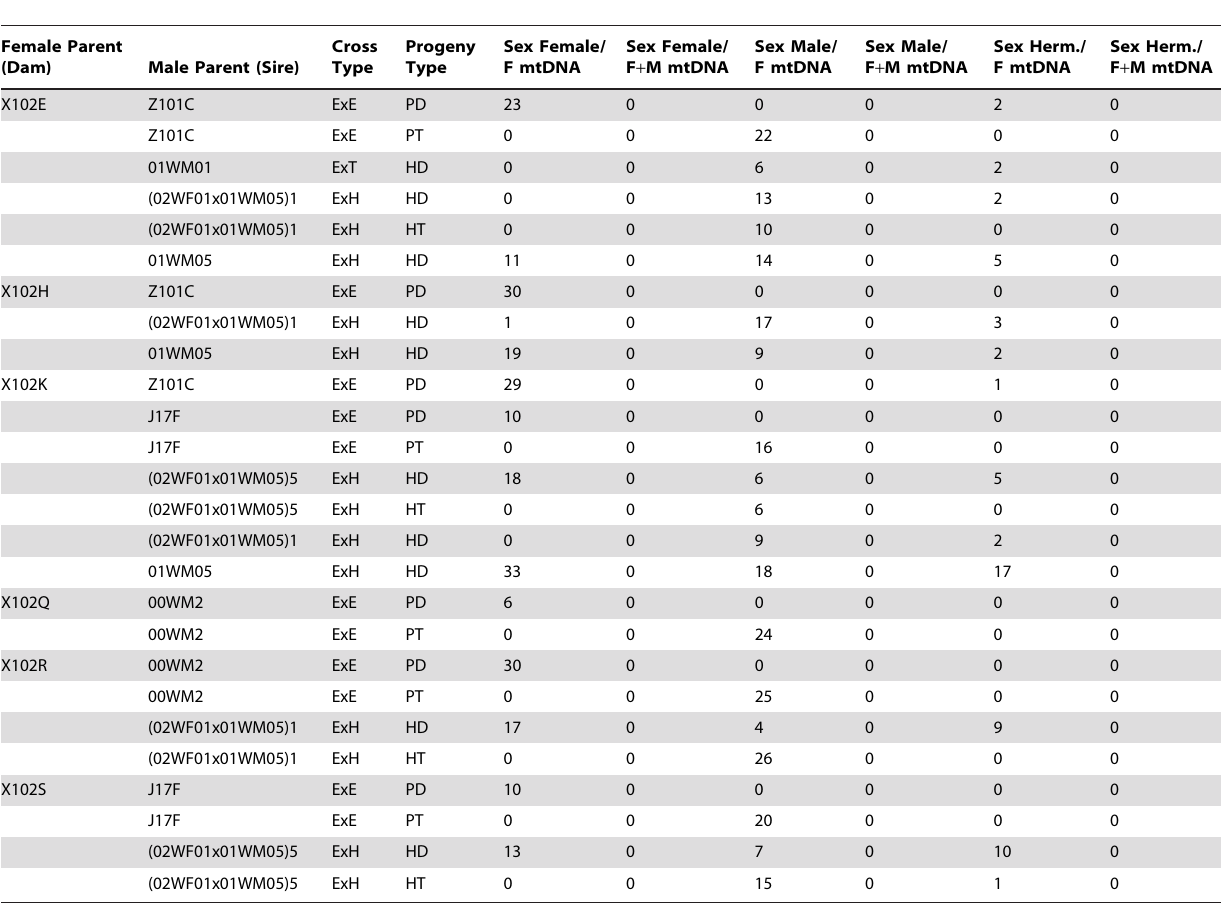
Table 2. Number of Progeny by Sex and Mitotype from Pure and Hybrid Crosses of Diploid and Triploid Mytilus Produced from Mothers Known to Produce Female-Biased